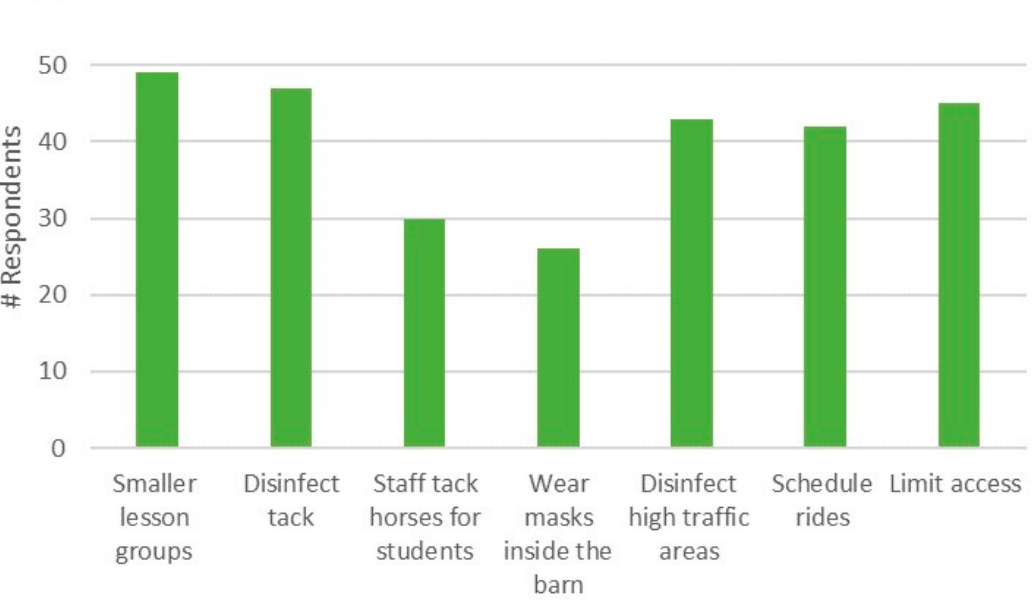
Figure 1. Precautions taken by survey respondents ( n = 60) to ensure safety during COVID-19 restrictions for riding lessons at equestrian facilities in Ontario. Note that respondents could check all options that applied .